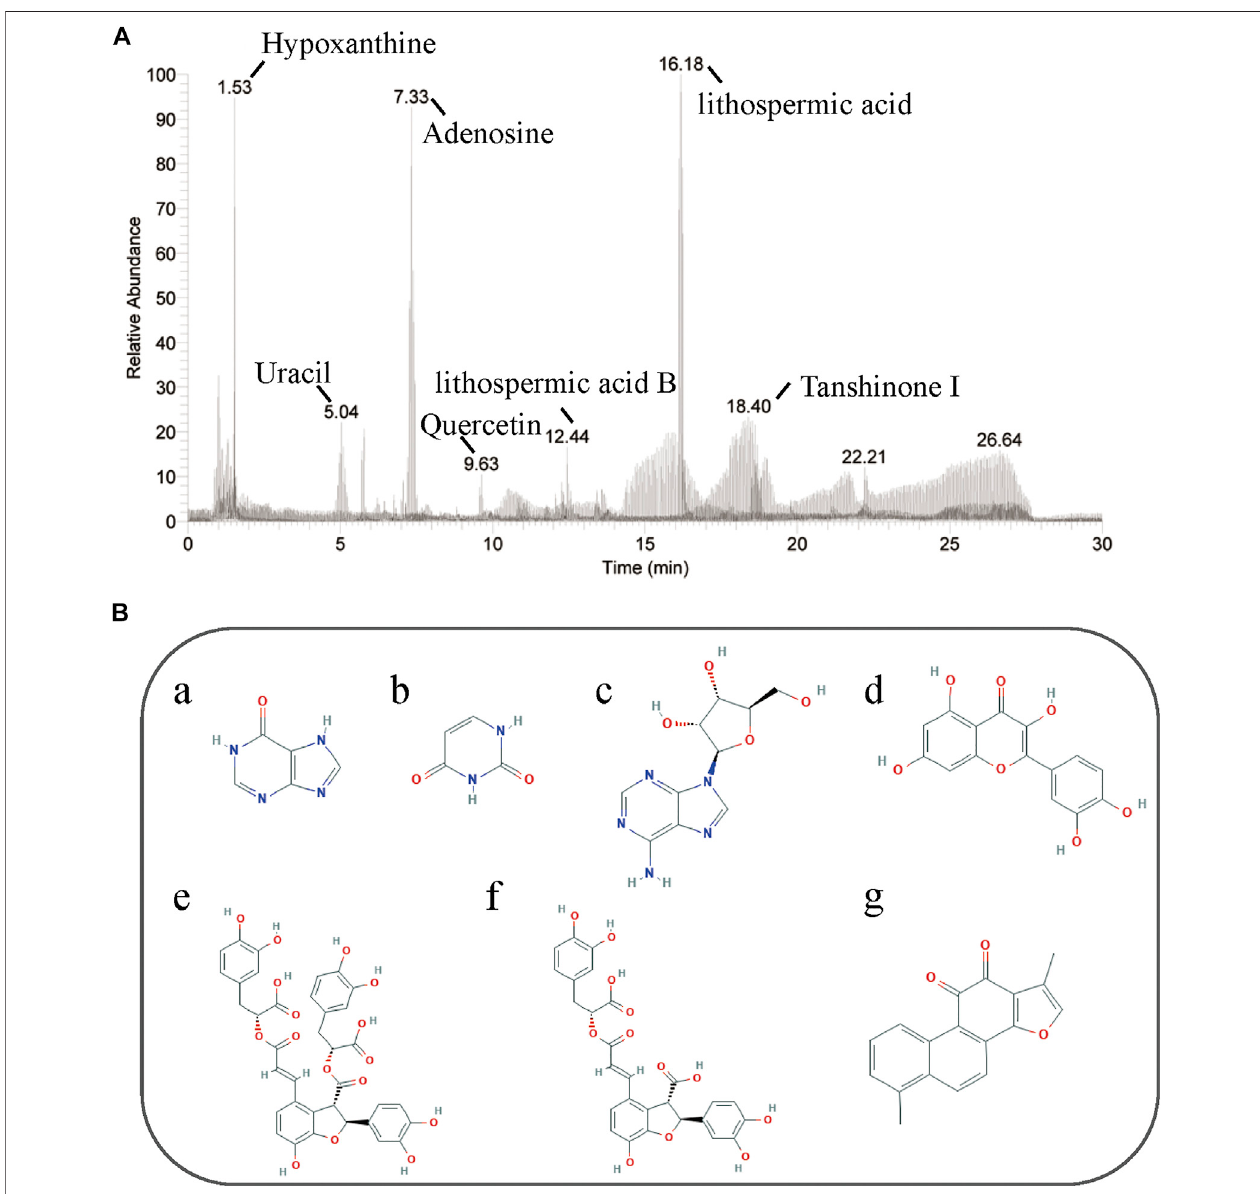
FIGURE1| HPLCofTTF. (A) SevenchemicalcompositionsinTTFwereidenti fi edbyHPLC. (B) Chemicalstructureof(a)hypoxanthine, (b)uracil,(c)adenosine,(d) quercetin, (e) lithospermic acid B, (f) lithospermic acid, (g) tanshinone I.